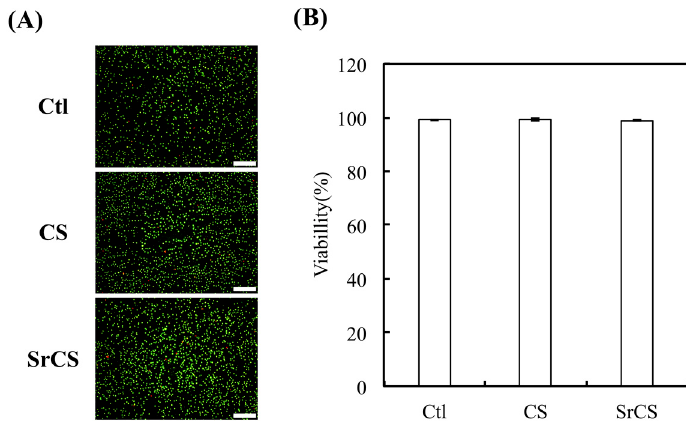
Figure 7. ( A ) The image and ( B ) quantification of live / dead assay results of L929 cultured in CS or SrCS extracts after 24 h cultivation. Data presented as mean ± SEM, n = 6 for each group. Scale bar: 400 µ m. Ctl: the cultured plate.